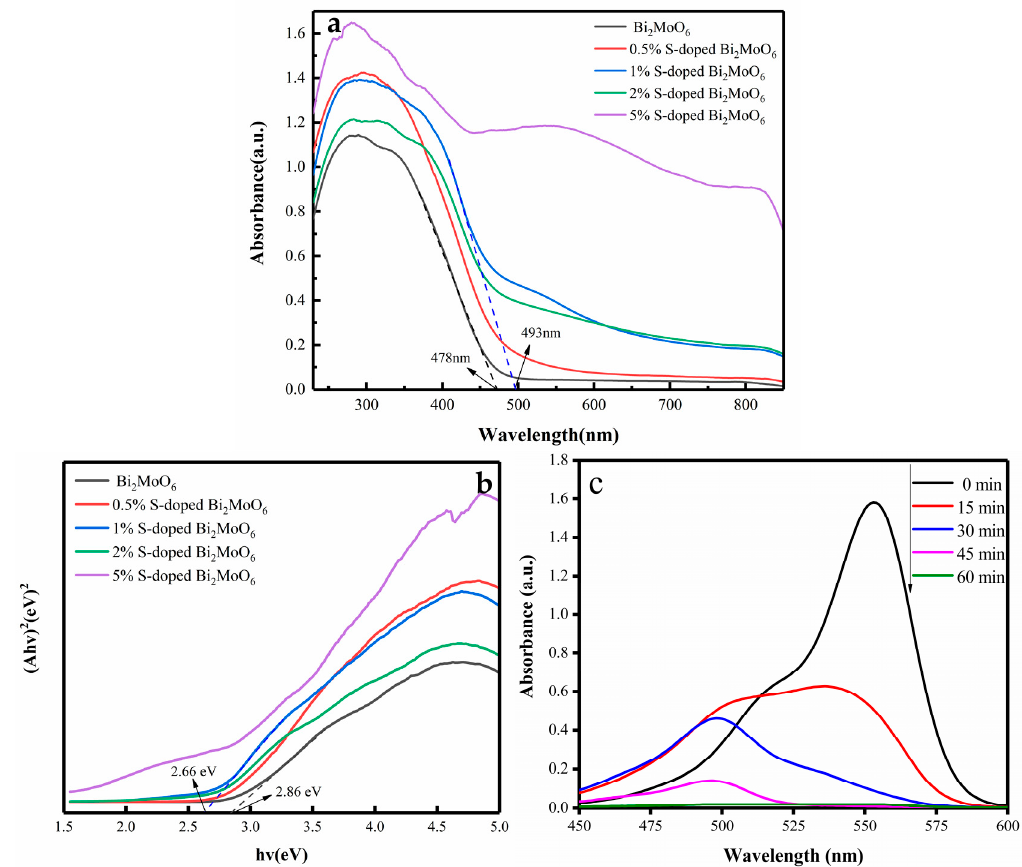
Figure 3. ( a ) UV-visible diffuse reflection spectra of the pure Bi 2 MoO 6 and Bi 2 MoO 6 with different S doping amounts, ( b ) band gap width of the pure Bi 2 MoO 6 and Bi 2 MoO 6 with different S doping amounts, ( c ) UV-visible absorption spectrum of 1% S-doped Bi 2 MoO 6 sample.